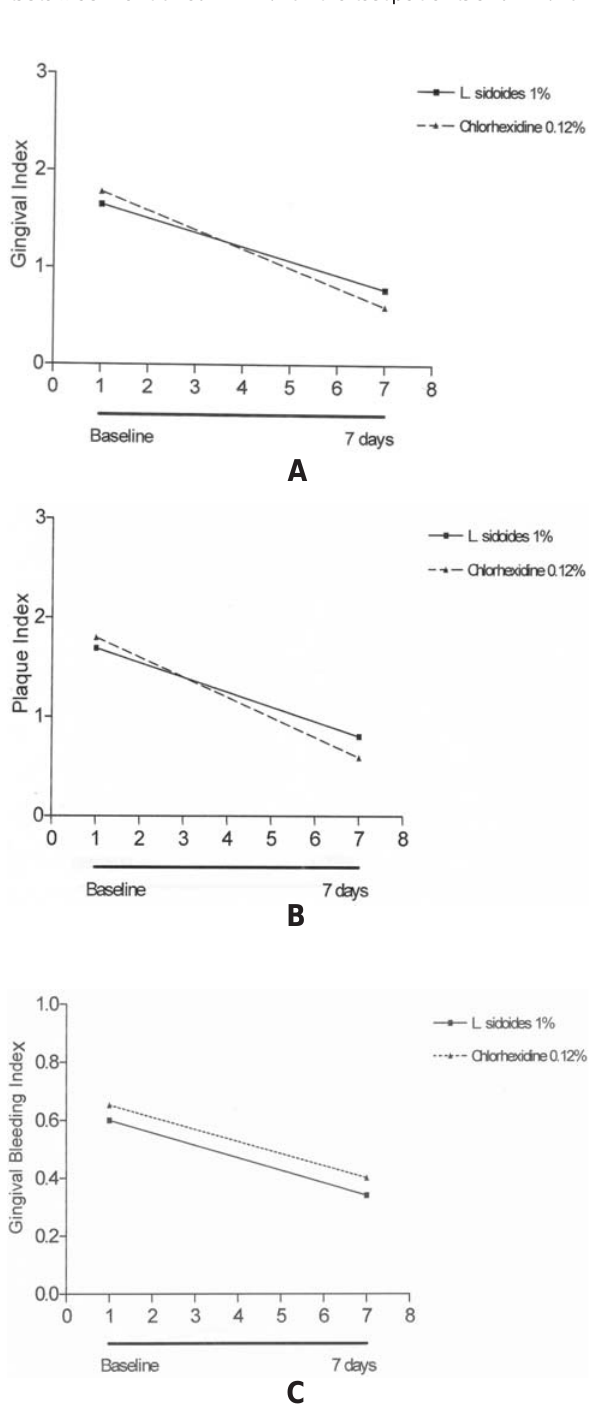
FIGURE 1- Effect of L. sidoides -based mouthrinse or 0.12% chlorhexidine mouthrinse on the clinical parameters.